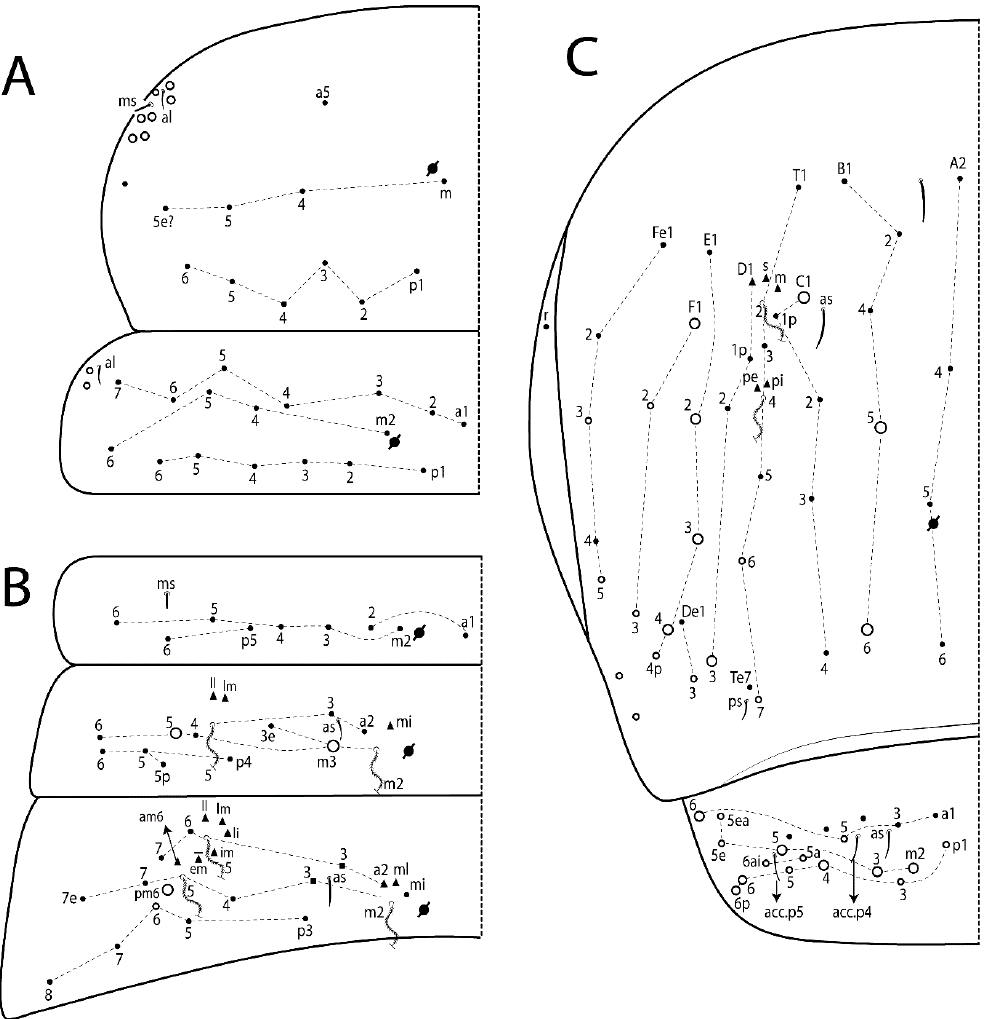
Figure 17. Pseudosinella keni sp. nov.: dorsal chaetotaxy. ( A ) Th II–III; ( B ) Abd I–III, arrow indicates part of Abd III central chaetotaxy; ( C ) Abd IV–V.